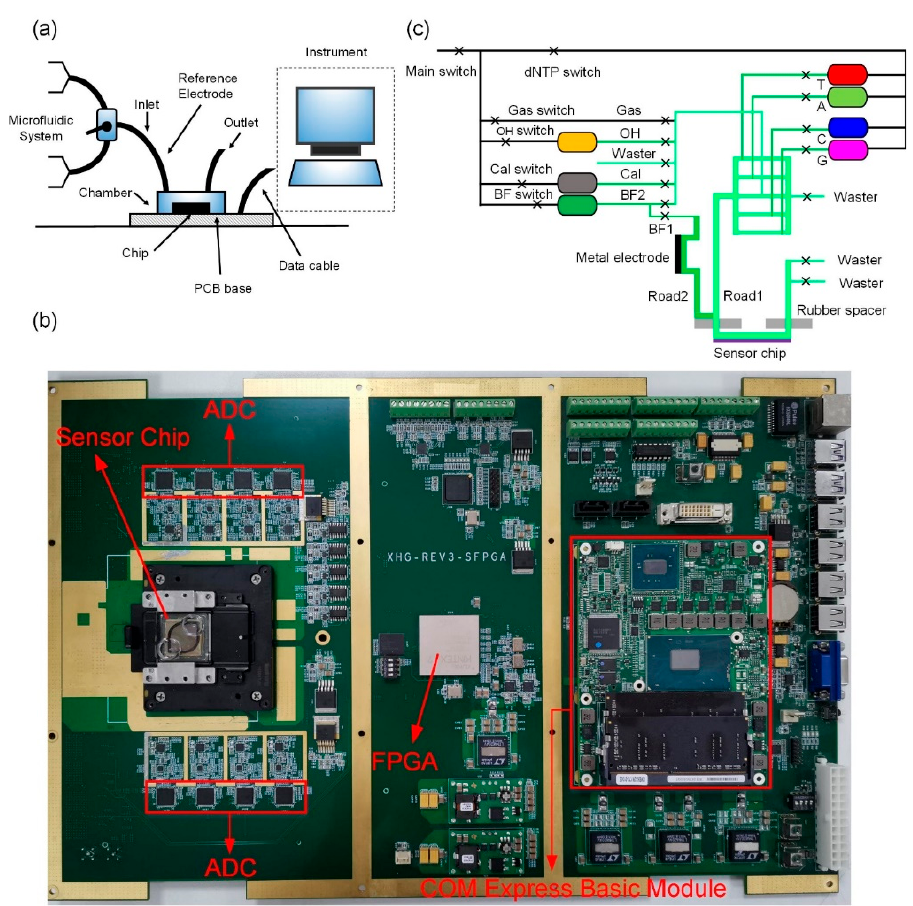
Figure 5. The system test platform and the microfluidic test system. ( a ) The test platform includes the microfluidic system, signal acquisition, and processing system; the signal acquisition and processing system is mainly composed of a high-speed PCB circuit board, which can achieve the acquisition speed of 9.52 ns per pixel, and the reading rate of the array is 128 frames per second. ( b ) Picture of the PCB control board. The main components of the PCB control board are the ADC, FPGA, and COM express basic module. The sensor chip is placed in the chip slot. ( c ) Microfluidic system controls the flow of different solutions by controlling the on and off states of different solenoid